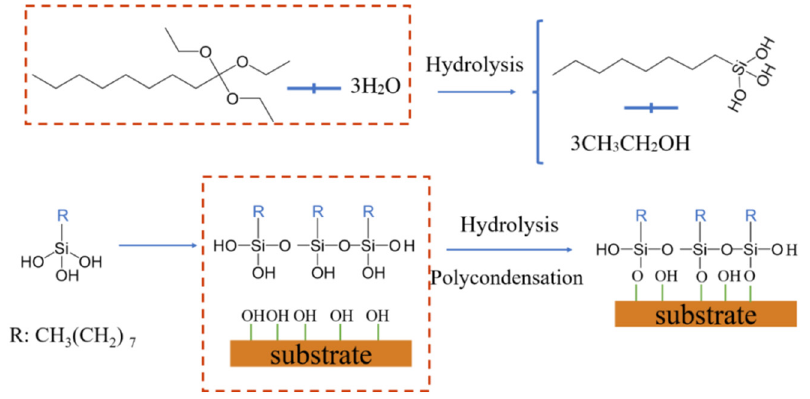
Figure 6. Mechanism of slag-based alkali activated materials coating formation (R = n-octyl).